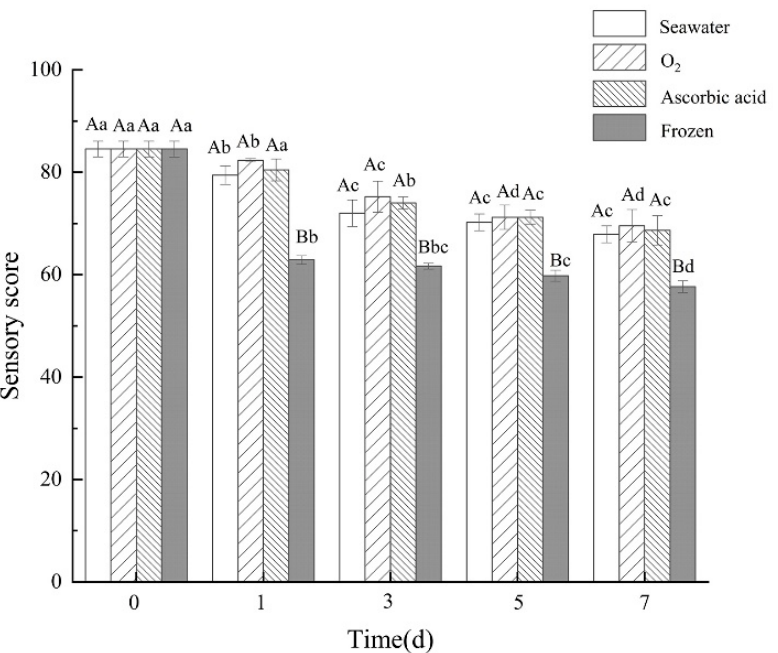
Figure 2. Sensory score of boiled sea cucumbers in different treatment groups during storage. Dates are presented as mean ± SD ( n = 6). Different capital letters indicate significant differences in the average between groups. Different lowercase letters indicate significant differences in the average value within each group ( p <